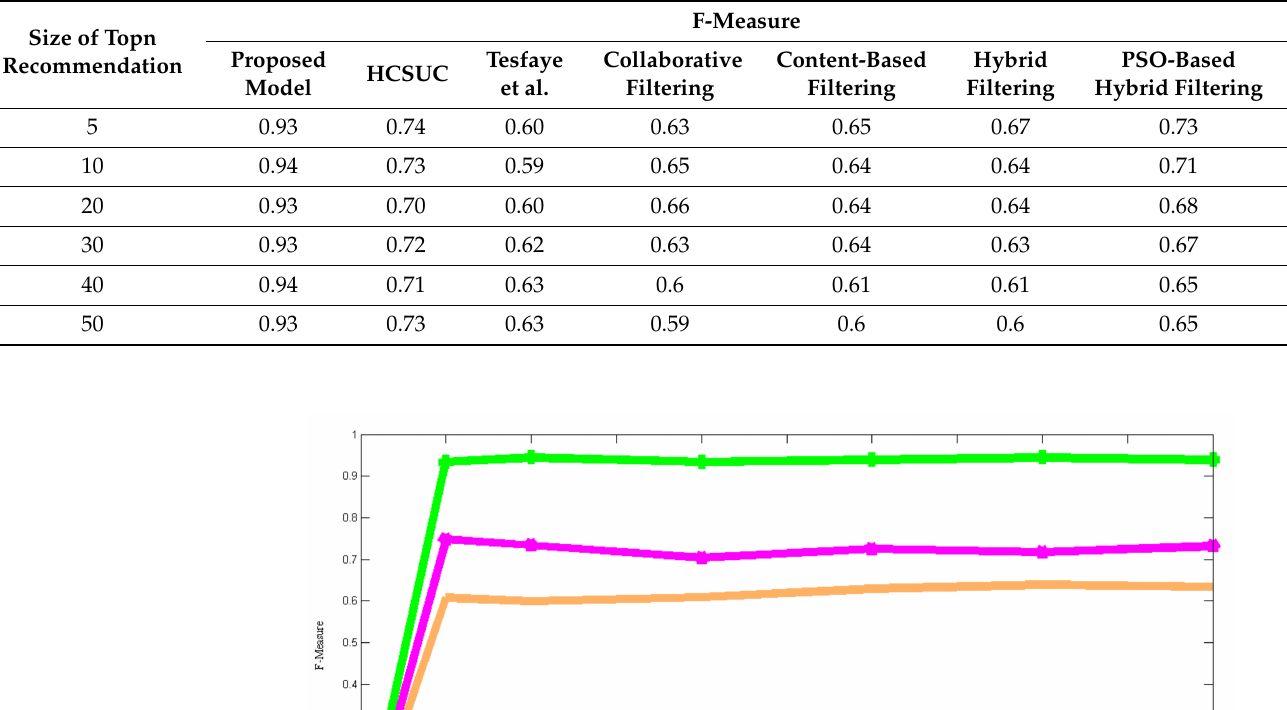
Table 7. F-Measure according to the Topn Recommendation (Considering Dataset 1 [43]).